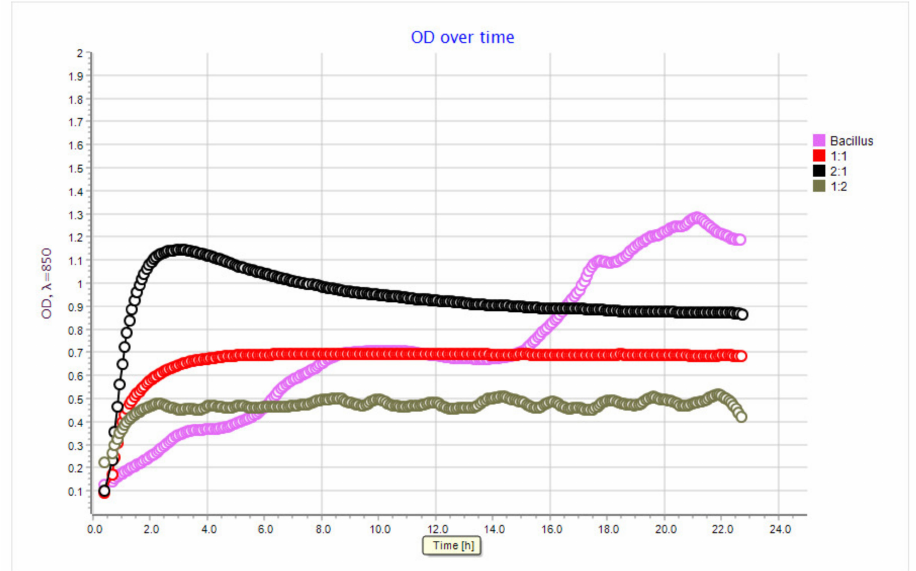
Figure 4. The influence of mixtures of S. baicalensis and Glycyrrhiza L. extracts on the growth of B . subtilis